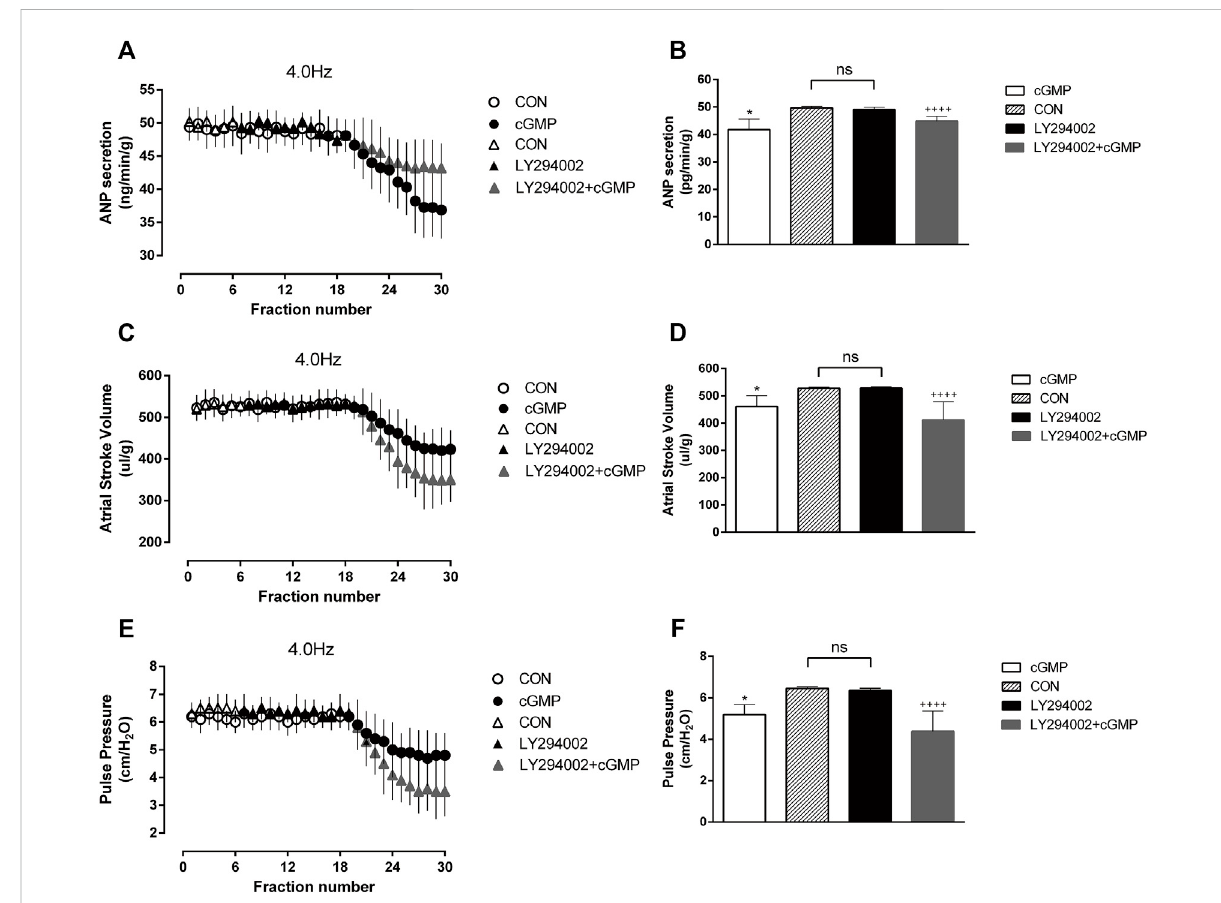
FIGURE 9 Effects of LY294002 on cGMP-induced ANP secretion and atrial dynamics under high-frequency stimulation. (A) Effects of the Akt inhibitor LY on ANP secretion under high-frequency stimulation. (B) Quantitative analysis of the effects of LY on ANP secretion under high-frequency stimulation. * p < 0.05 vs. LY + cGMP; ++++ p < 0.0001 vs. LY. (C) Effects of LY on atrial stroke volume under high-frequency stimulation. (D) Quantitative analysis of the effects of LY on atrial stroke volume under high-frequency stimulation. * p < 0.05 vs. LY + cGMP; ++++ p < 0.0001 vs. LY. (E) Effects of LY on atrial pulse pressure under high-frequency stimulation. (F) Quantitative analysis of the effects of LY on atrial pulse pressure underhigh-frequencystimulation. * p < 0.05vs.LY+cGMP; ++++ p < 0.0001vs.LY. Dataareexpressedasmean±SEMs, n =6.(PSCONandcGMPare from Figure